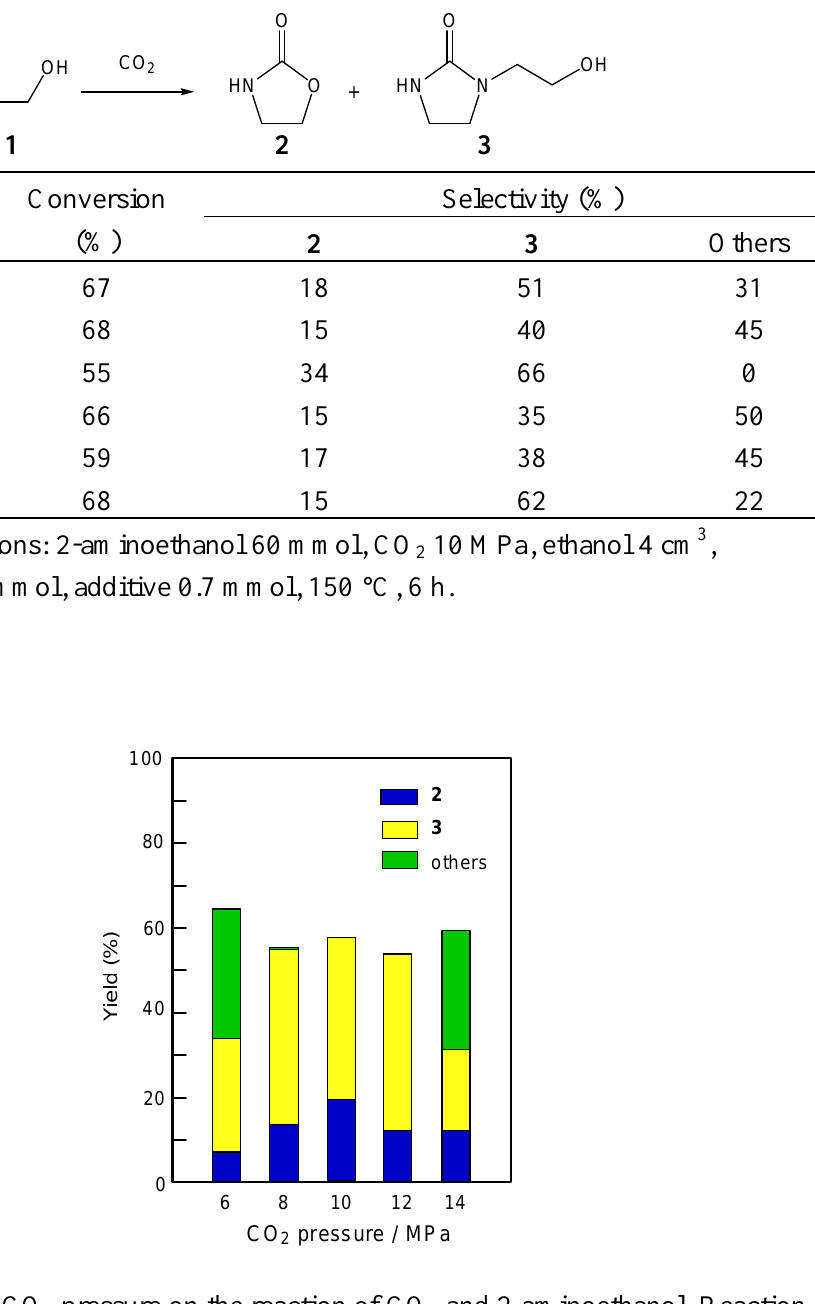
Figure 2. Influence of CO 2-aminoethanol, 60 mmol; ethanol, 4 cm 3 ; BMIM-Br, 11.4 mmol; K